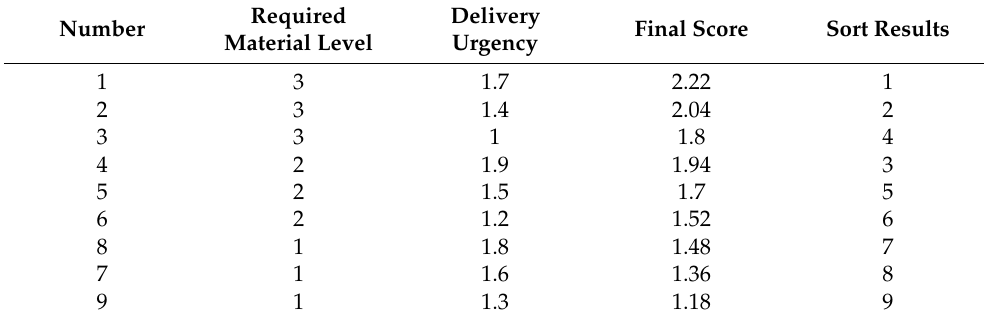
Table 6. Final priority.